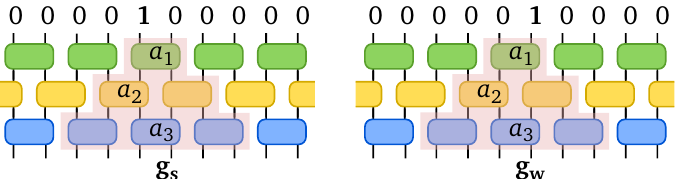
Figure 7: Illustration of Eq. (31), which gives the equations the a order for the circuit to implement W